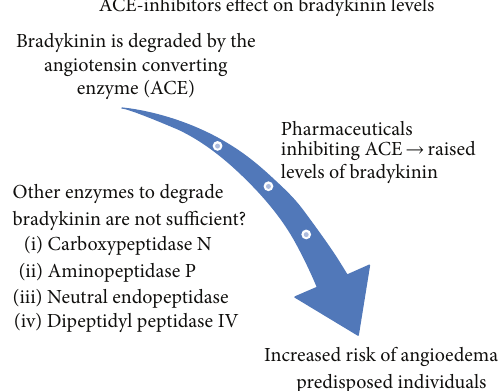
Figure 1: Some scientists hypothesize that patients might be predisposed to develop angioedema due to DNA mutations in the genes encoding the enzymes of the bradykinin pathway